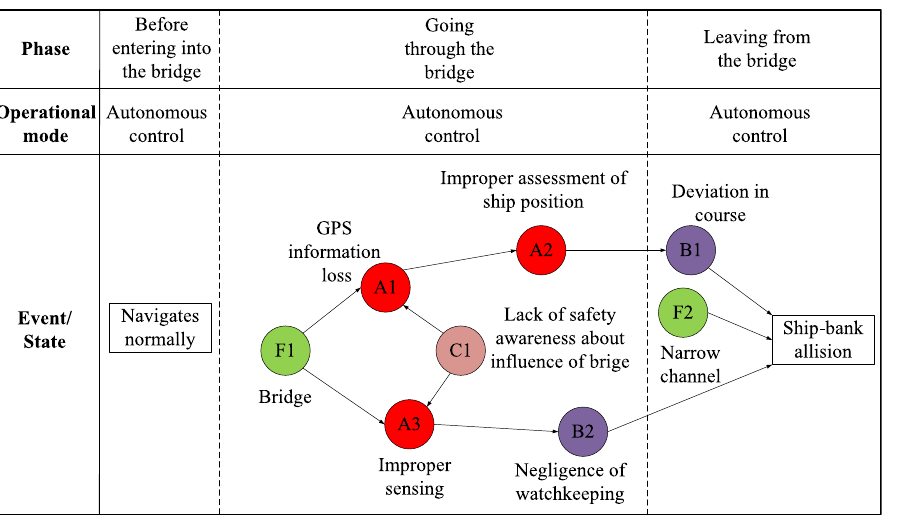
Figure 3. Accident analysis based on 24 Model.